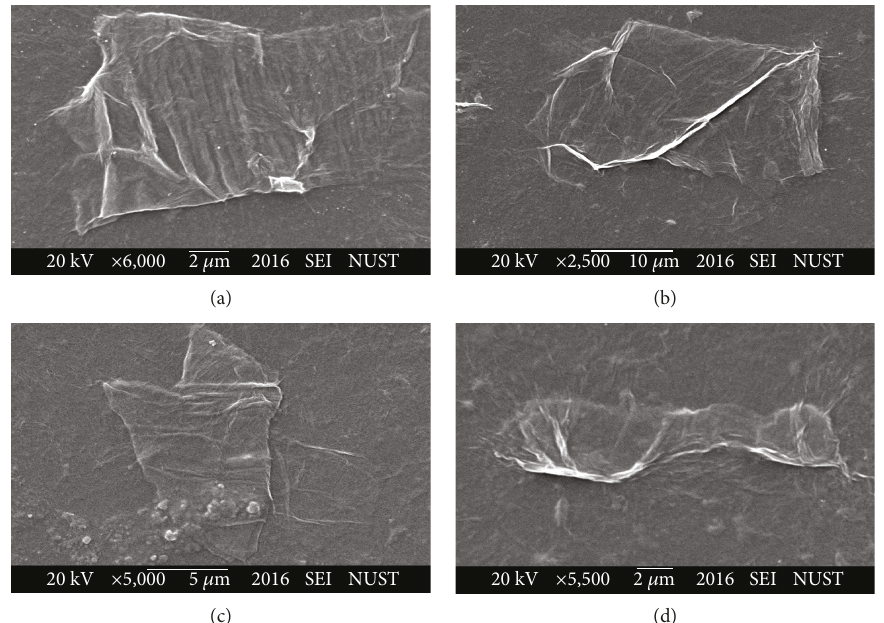
Figure 4: SEM micrographs of the prepared graphene oxide (GO).